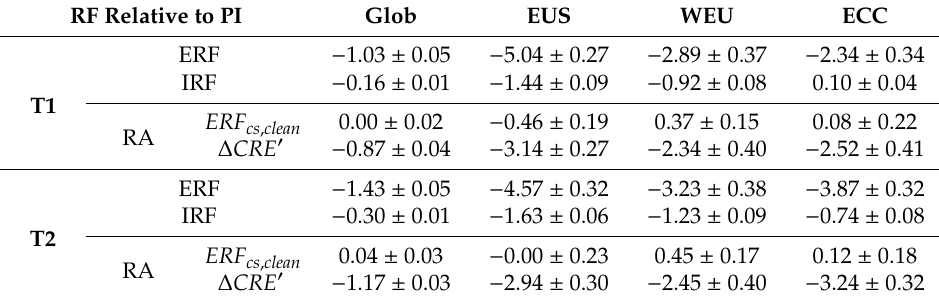
Table 2. Global and regional means of e ff ective radiative forcing (ERF, W/m 2 ), instantaneous radiative forcing (IRF, W/m 2 ), and rapid adjustment (RA, W/m 2 ), including a component due to any non-aerosol change in clear-sky flux ( ERF cs , clean , W/m 2 ) and cloud property changes ( ∆ CRE (1940–1970) and T2 (1980–2010) periods relative to the pre-industrial period (PI) (1850), including an estimate of the standard error (Forster et al.,